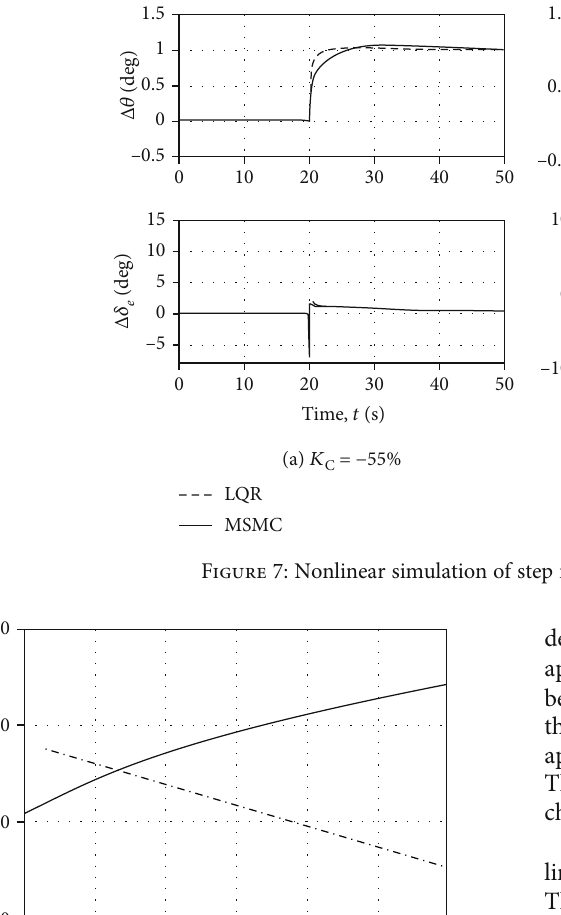
. Solid line: K min for speci fi c input n n